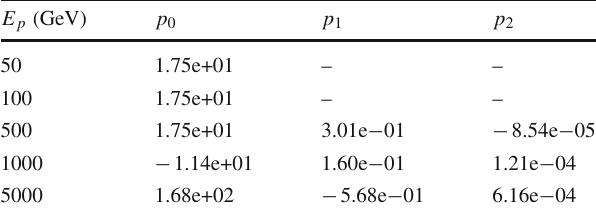
Table 3 Best fit parameters for the function r 50 ( X sl ) = p 0 + p 1 X sl +